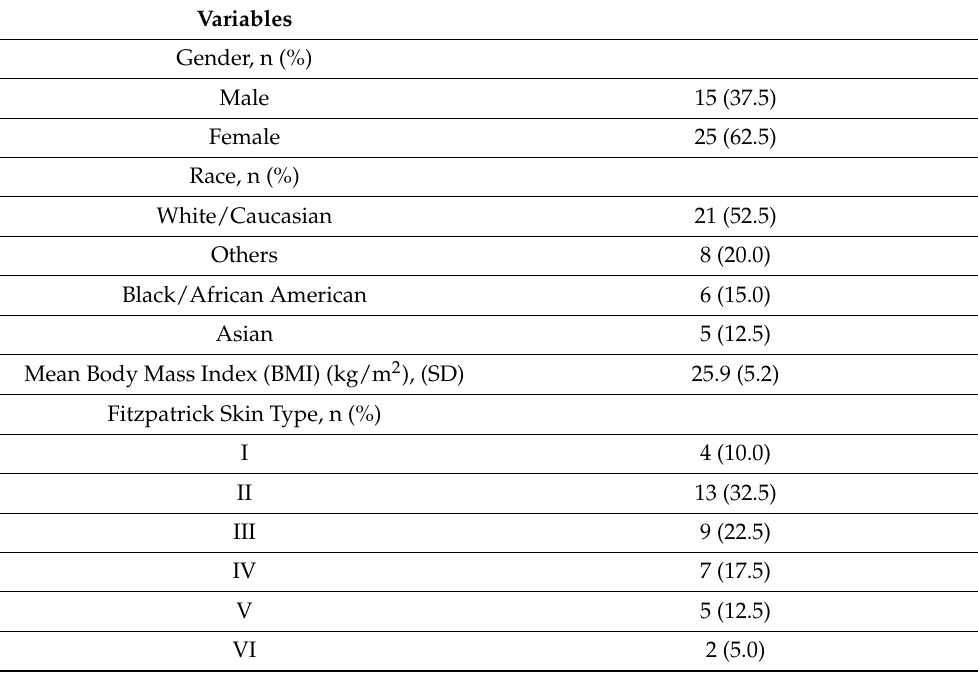
Table 1. Demographic characteristics (n = 40).